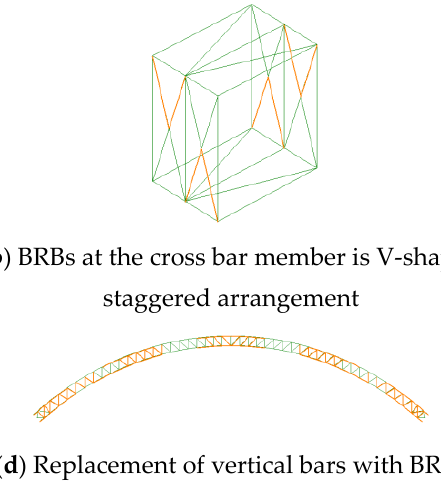
Figure 11. BRB layout scheme. Table 7. BRB layout quantity table.